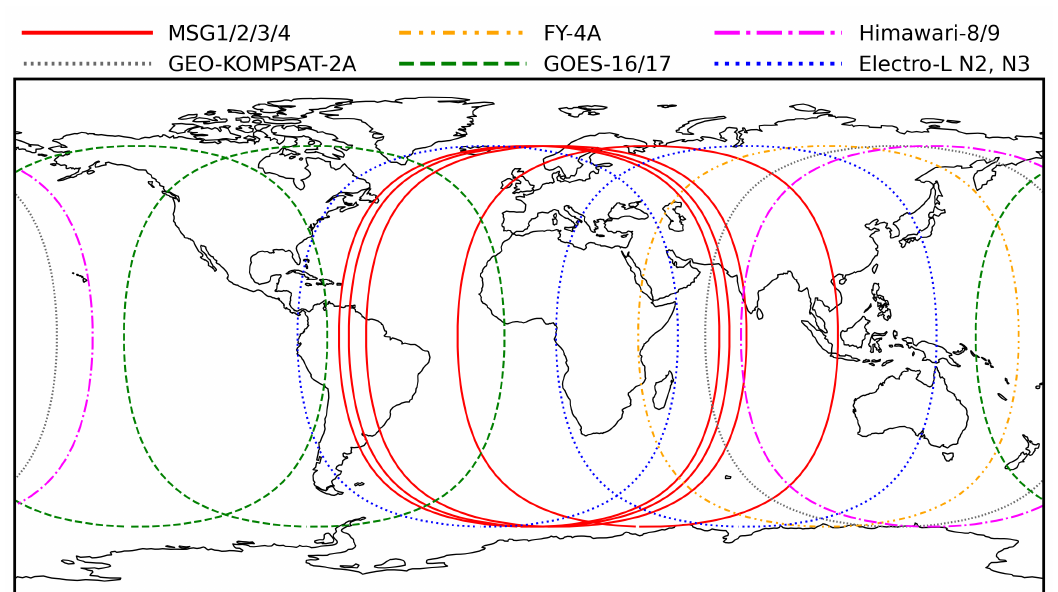
Figure 1. Field of view of all currently active advanced moderate-resolution optical imagers aboard geostationary satellites. The colored borders correspond to viewing zenith angles of 75 ◦